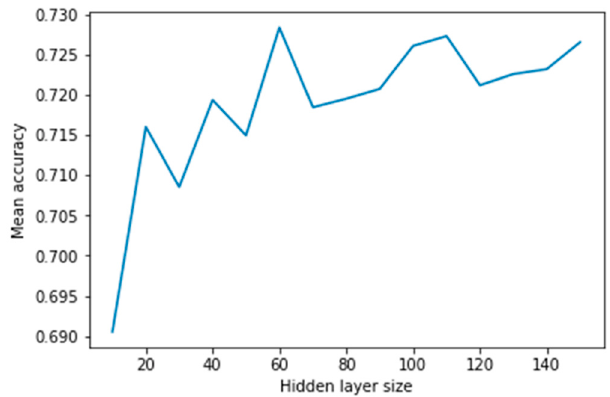
Figure 10. Mean accuracy of the respondent’s authenticity classifier depending on the number of neurons in the hidden layer.